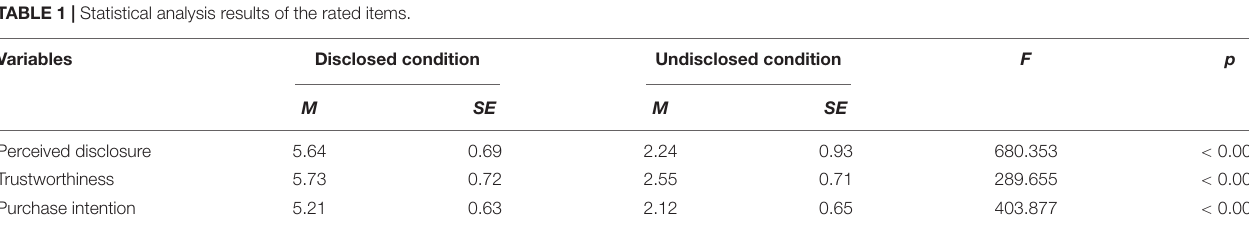
FIGURE 2 | Behavioral results. The purchase rate and reaction time for each condition are shown. Error bars denote the standard error of the mean. ∗∗∗ p < 0.001. TABLE 1 | Statistical analysis results of the rated